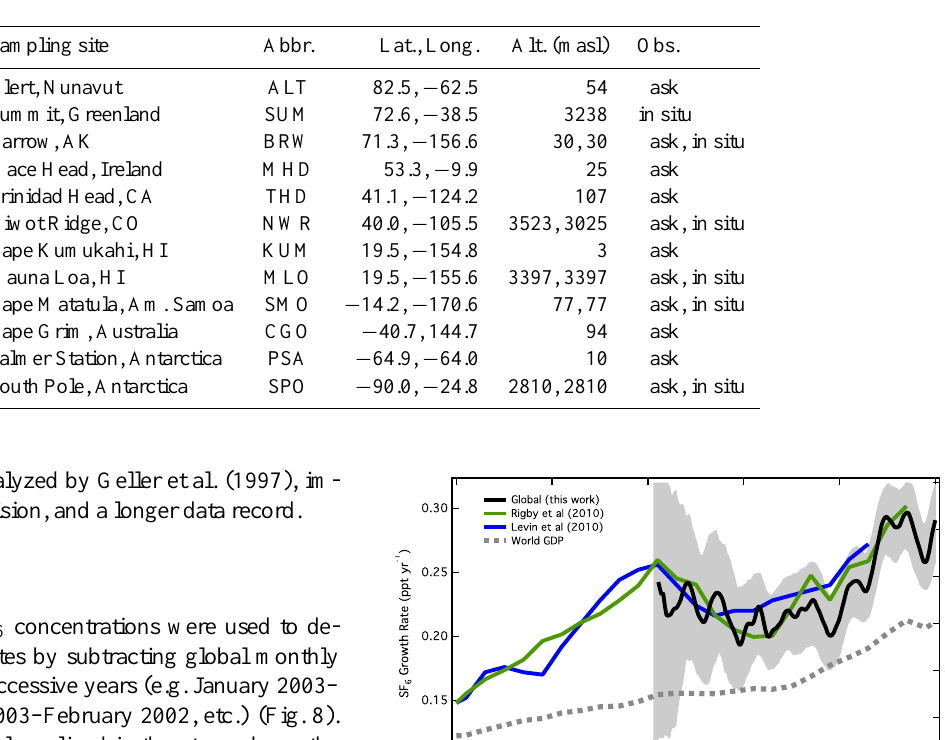
Table 3. Sampling sites.